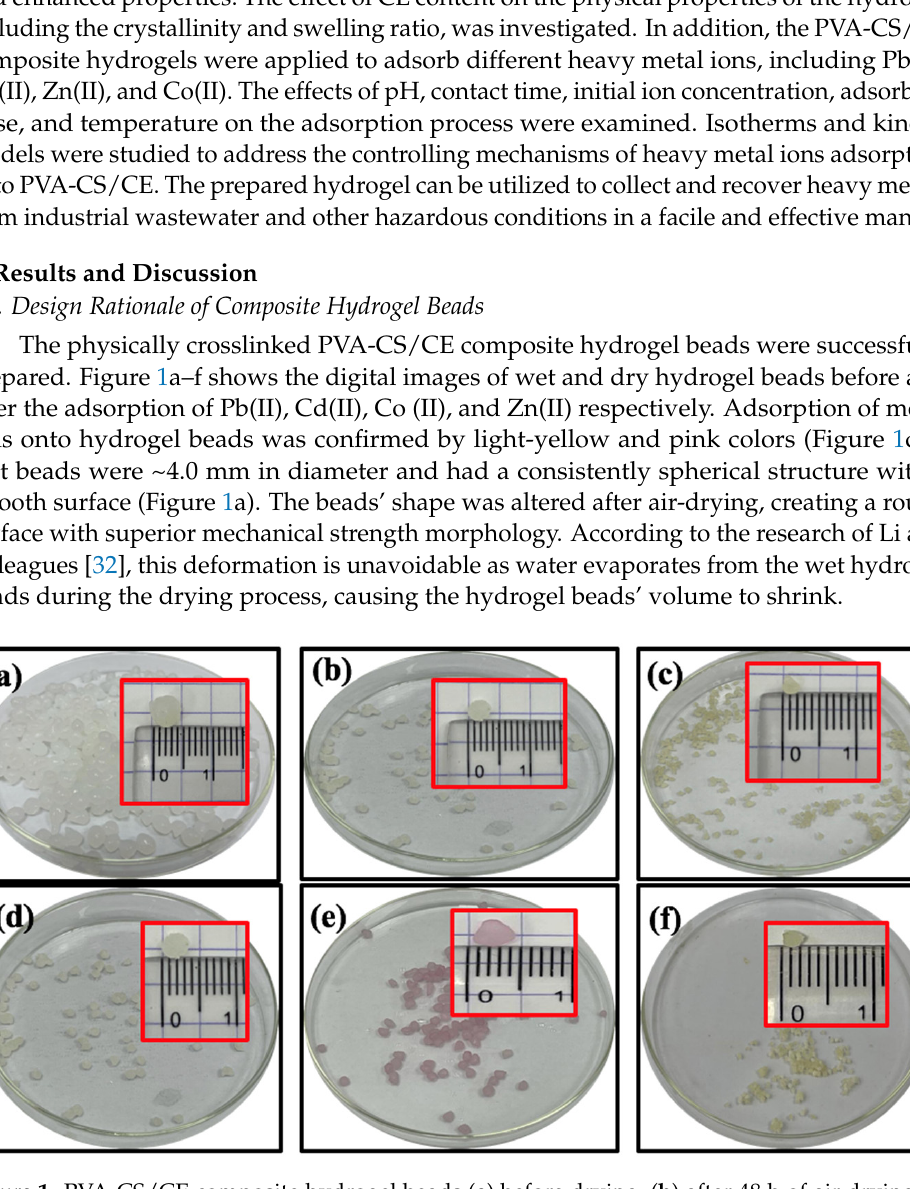
Figure 1. PVA-CS/CE composite hydrogel beads ( a ) before drying, ( b ) after 48 h of air drying, as well as dried beads after adsorption of ( c ) Pb(II), ( d ) Cd(II), ( e ) Co(II), or ( f ) Zn(II). Insets show the size of